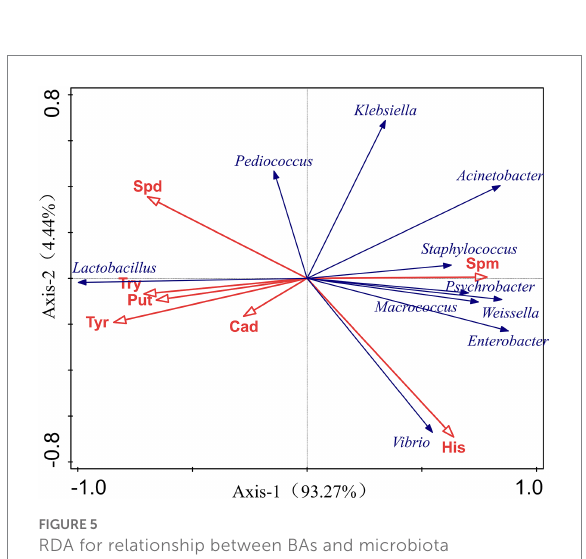
FIGURE 5 RDA for relationship between BAs and microbiota composition based on the top 10 dominant microbes at genus